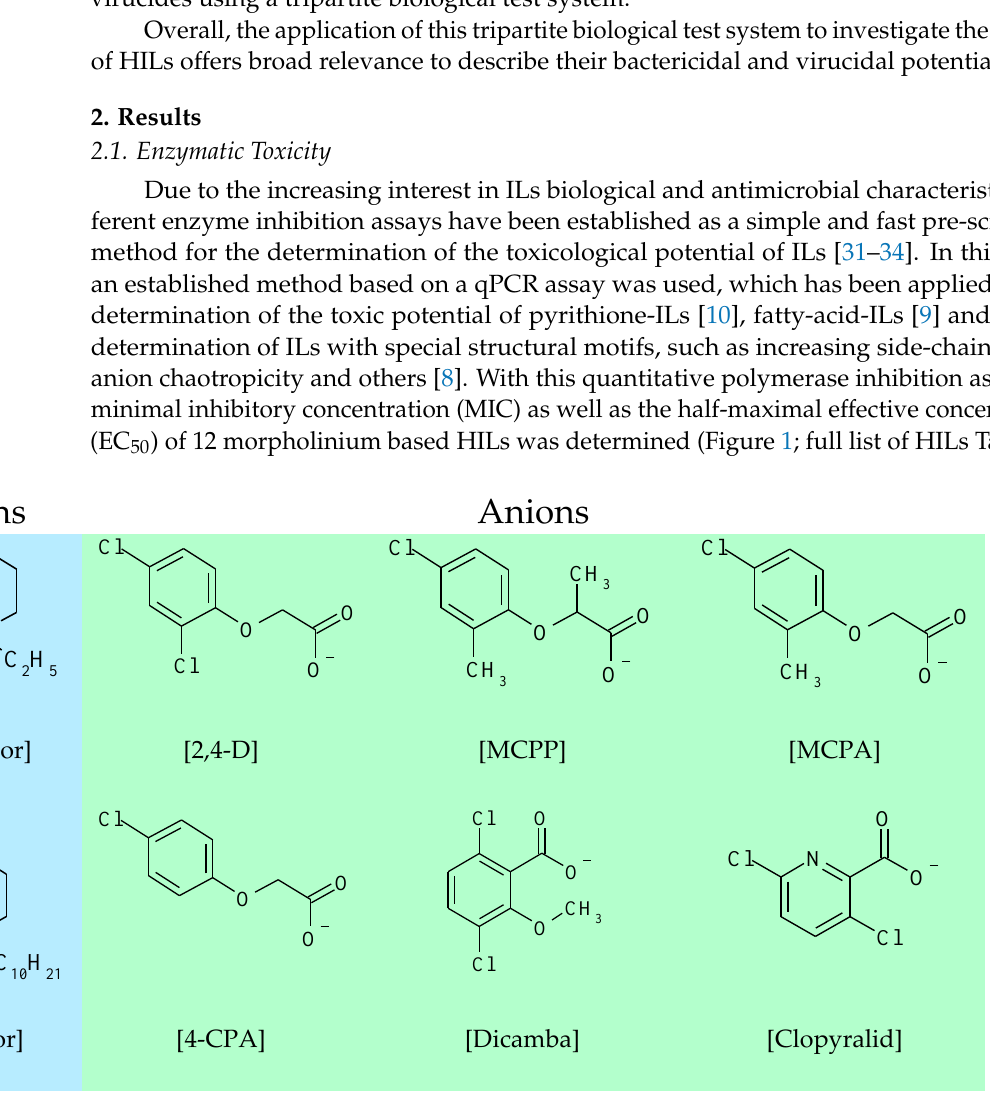
Figure 1. Graphic representation of all cations and anions of morpholinium based HILs investigated in this study.